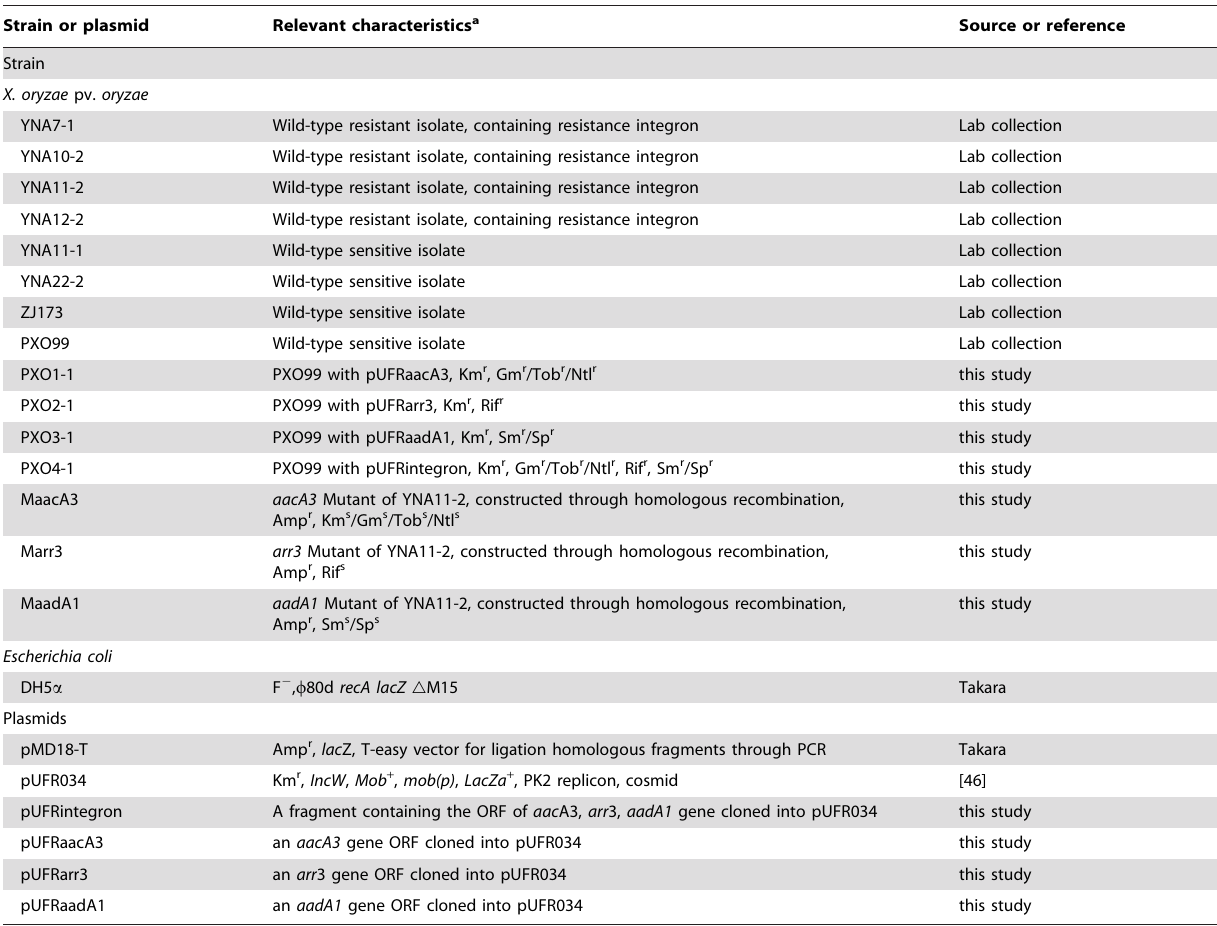
Table 1. Bacterial strains and